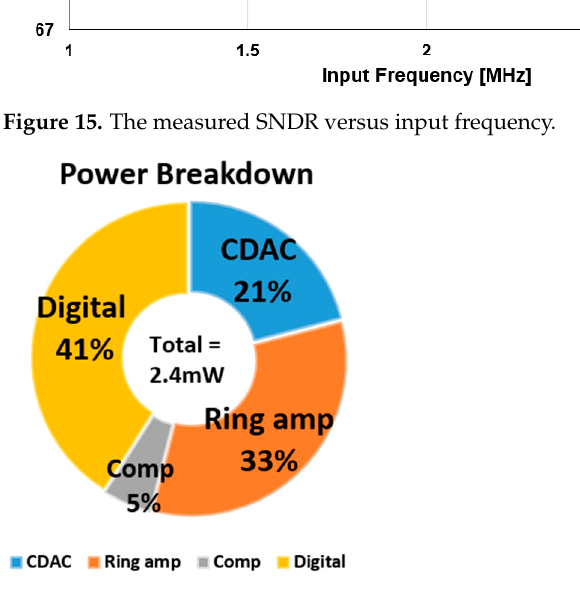
Figure 16. The power consumption breakdown of the proposed ADC.